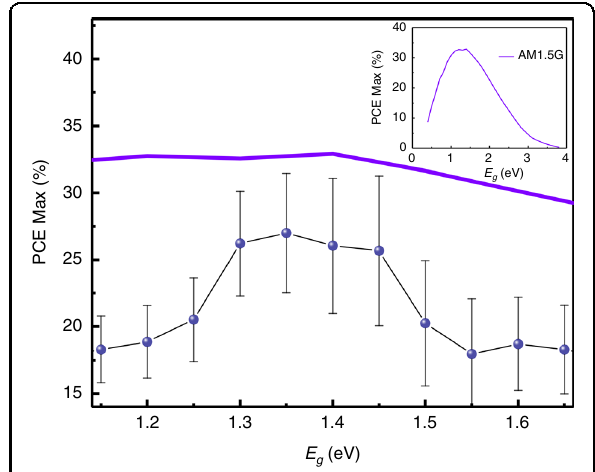
Fig. 4 The obtained relationship between PCE and E g from different ways. The black and violet lines represent the maximumpredicted PCE with regard to E g and the theoretical limit of PCE fromShockley – Queisser (S – Q) limit, respectively. The inset is the reduction curveof S – Q